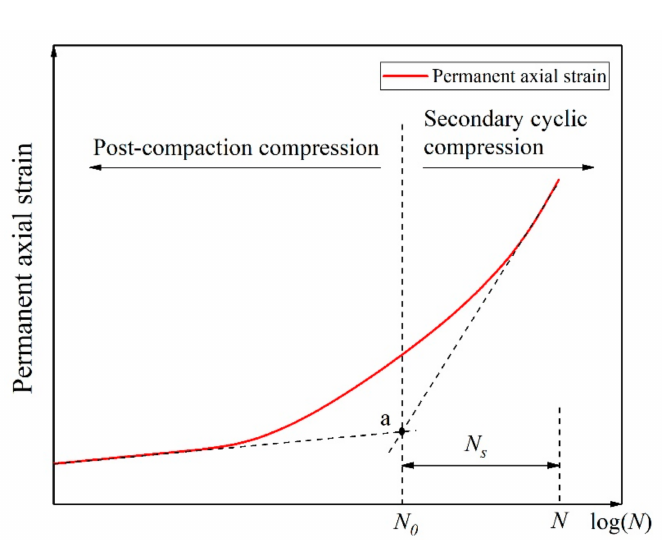
Figure 2. Selection of numbers of rotating axial compression cycles, reprinted with permission from [28]. Copyright 2019